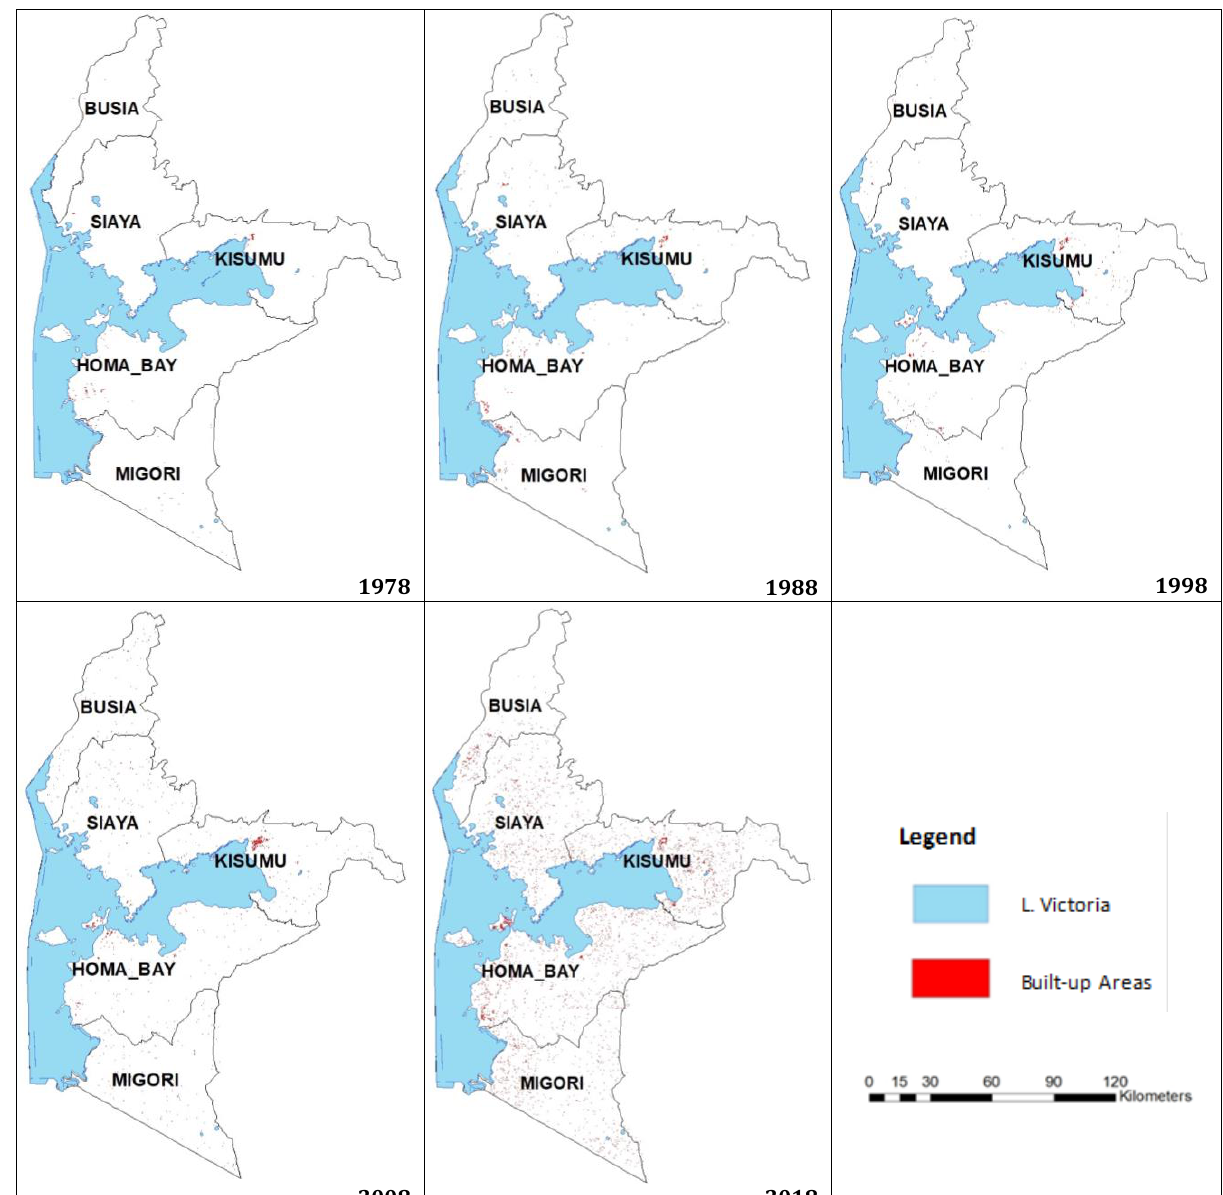
Fig. 3. Built-up area maps of the Lake Victoria basin for 1978, 1988, 1998, 2008 and 2018 Table 1. Statistics of the built-up areas in the Kenyan